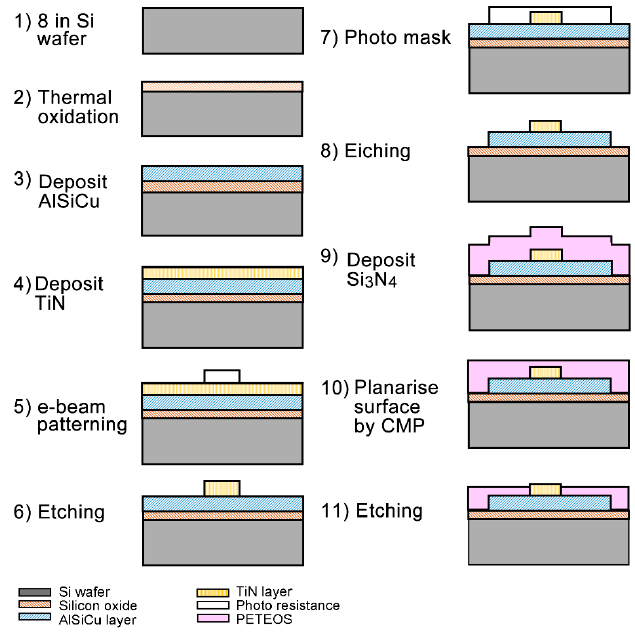
Figure 2. Fabrication procedures of standard CMOS process to construct a sensing chip with 3D-NEA.